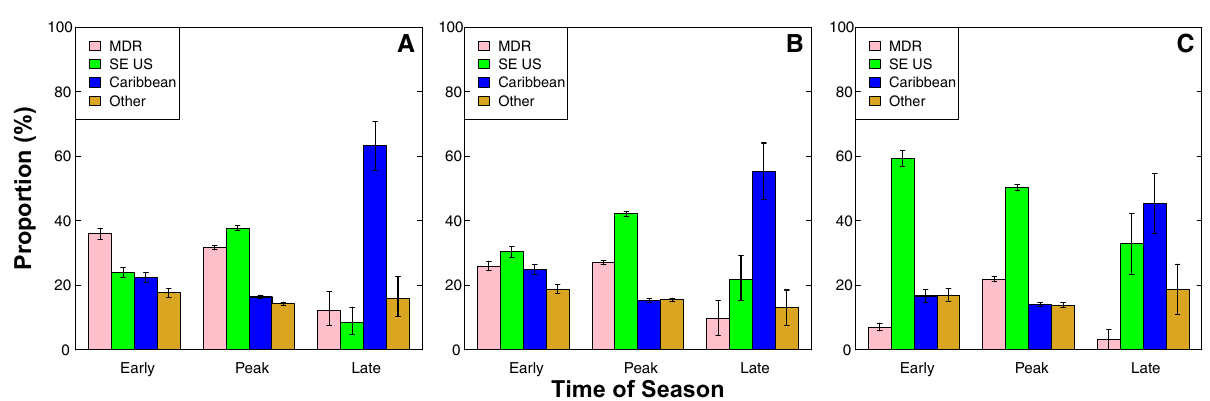
Figure 3. Bar graphs displaying the amount of TC genesis in each region during each part of the season. Bars show seasonal amounts of TC genesis during ( A ) the pre-industrial era, ( B ) the modern era, and ( C ) the future era. Error bars show bootstrapped 90% credible intervals.